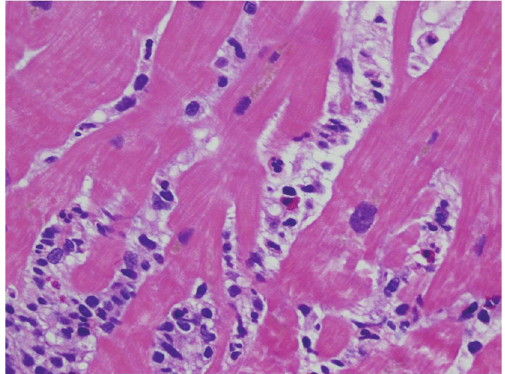
Figure 4: Right ventricular biopsy demonstrating interstitial inflammatory cell infiltrate in the myocardium, H&E stained with × 400 magnification. Most infiltrating cells are mononuclear cells, admixed with occasional eosinophils.